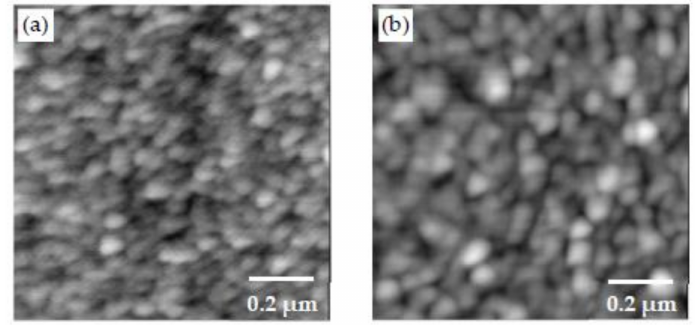
Figure 8. AFM image of ( a ) PDDA/PAA-CSH and ( b ) PDDA/PAA-CSH-HighpH made of three bilayers. Table 4. Roughness value, number of particles, and mean area of the CSH particles in